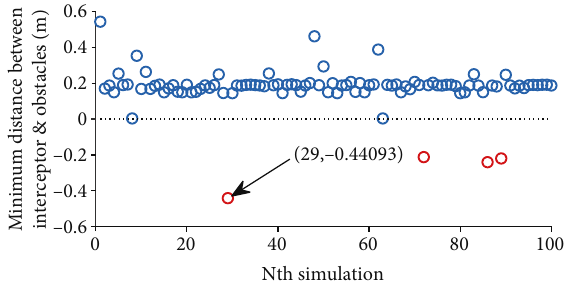
Figure 32: Minimum distance between the interceptor and obstacles of each